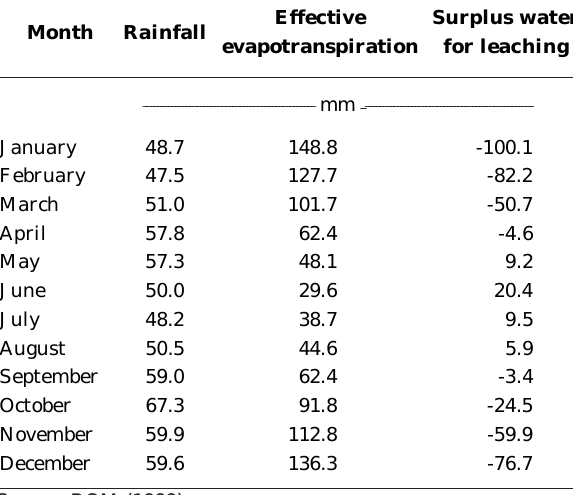
Table 3. Some long-term climate data for Melbourne Effective Month Rainfall